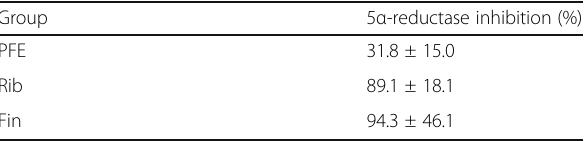
Table 1 Inhibitory effects of PFE, Rib and Fin on 5 α -reductase activity in rat prostate Group